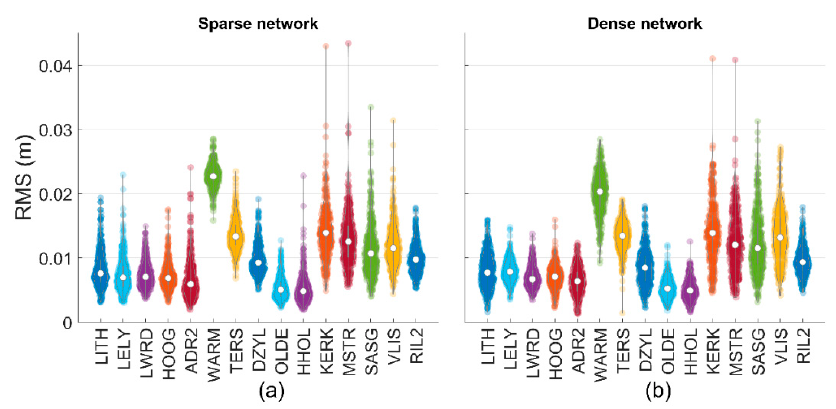
Figure 12. Violin plot of the RMSEs of each user station in ( a ) the sparse network and ( b ) the dense network. Stations from the left to the right are sequential 5 inside the network, 5 on the edge of the network and 5 outside the network.